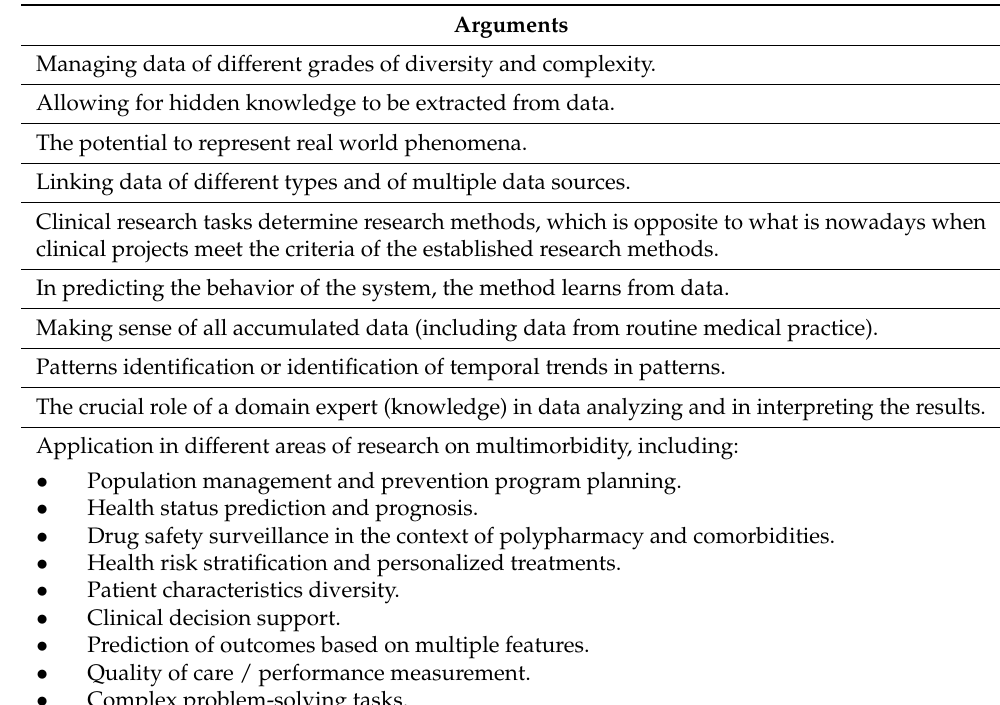
Table 3. The arguments to use the Machine Learning/Big Data-AI approaches in research on multimorbidity [29,30,45].